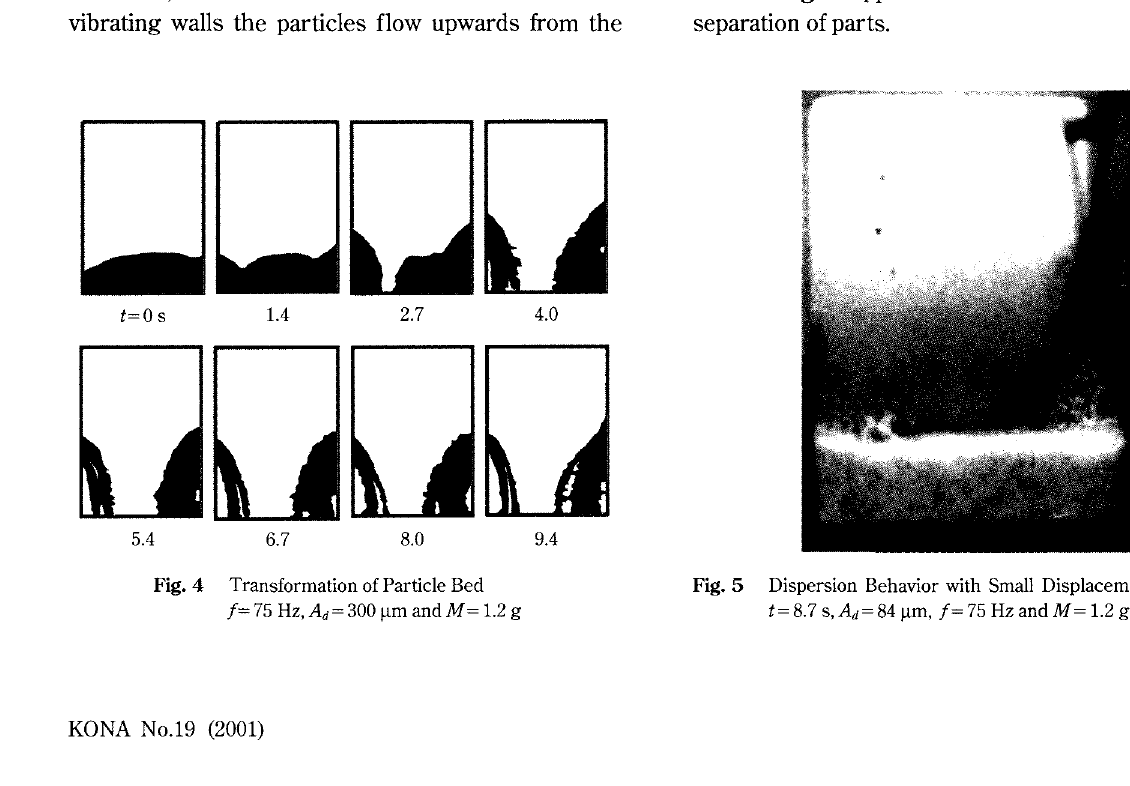
Fig. 4 Transformation of Particle Bed Fig. 5 Dispersion Behavior with Small Displacement Amplitude t= 8.7 s,Ad=84!lm, f= 75Hz and M= 1.2